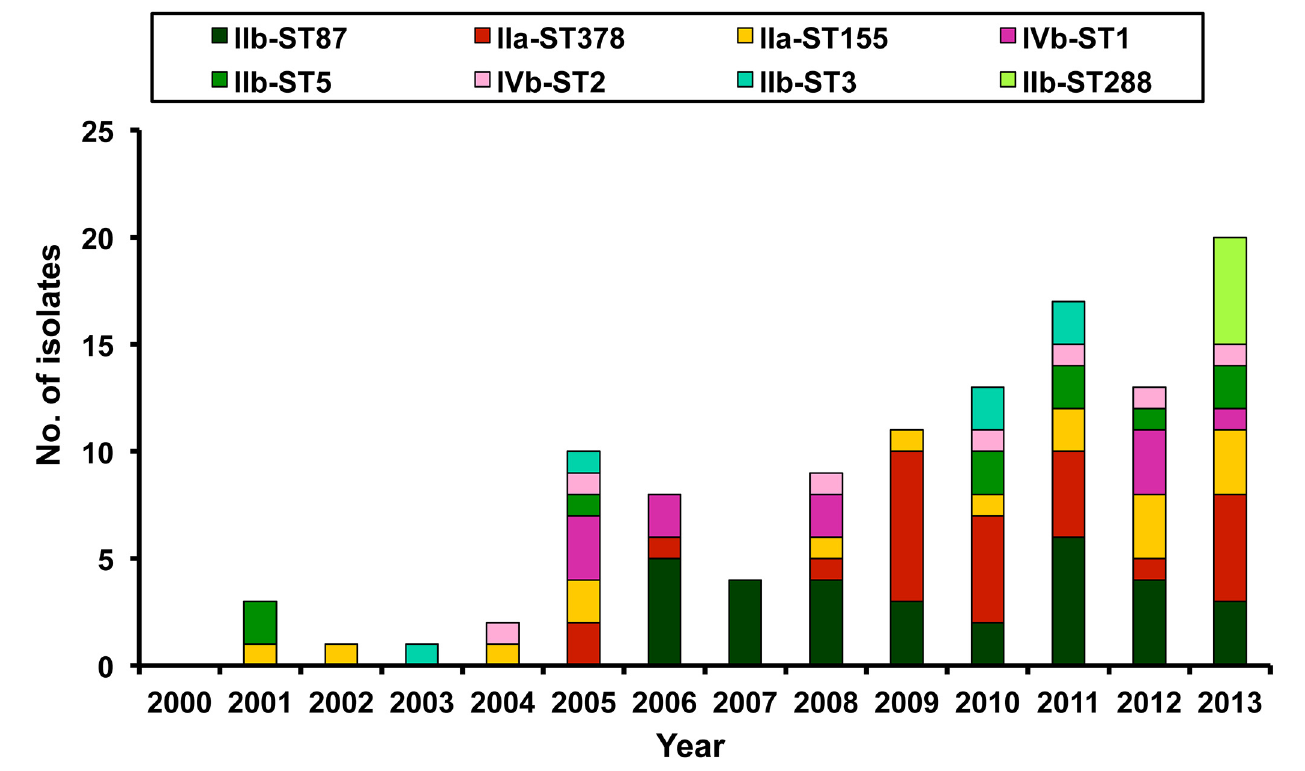
Fig 4. Distribution of main PCR serogroup-sequence type (ST) among L . monocytogenes Distribution of eight main PCR serogroup-sequence type (ST) isolates (no. of isolates (cid:1) 5) among 132 L . monocytogenes isolates collected from three medical centers in Taiwan from 2000 to 2013 by year.